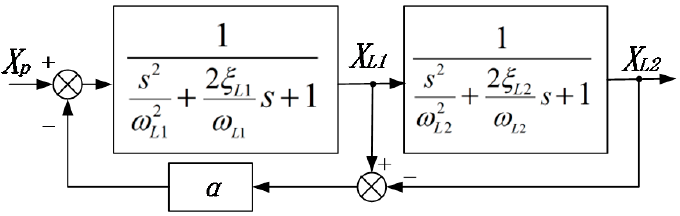
Figure 4. The control block diagram presentation of Equations (8) and (9).